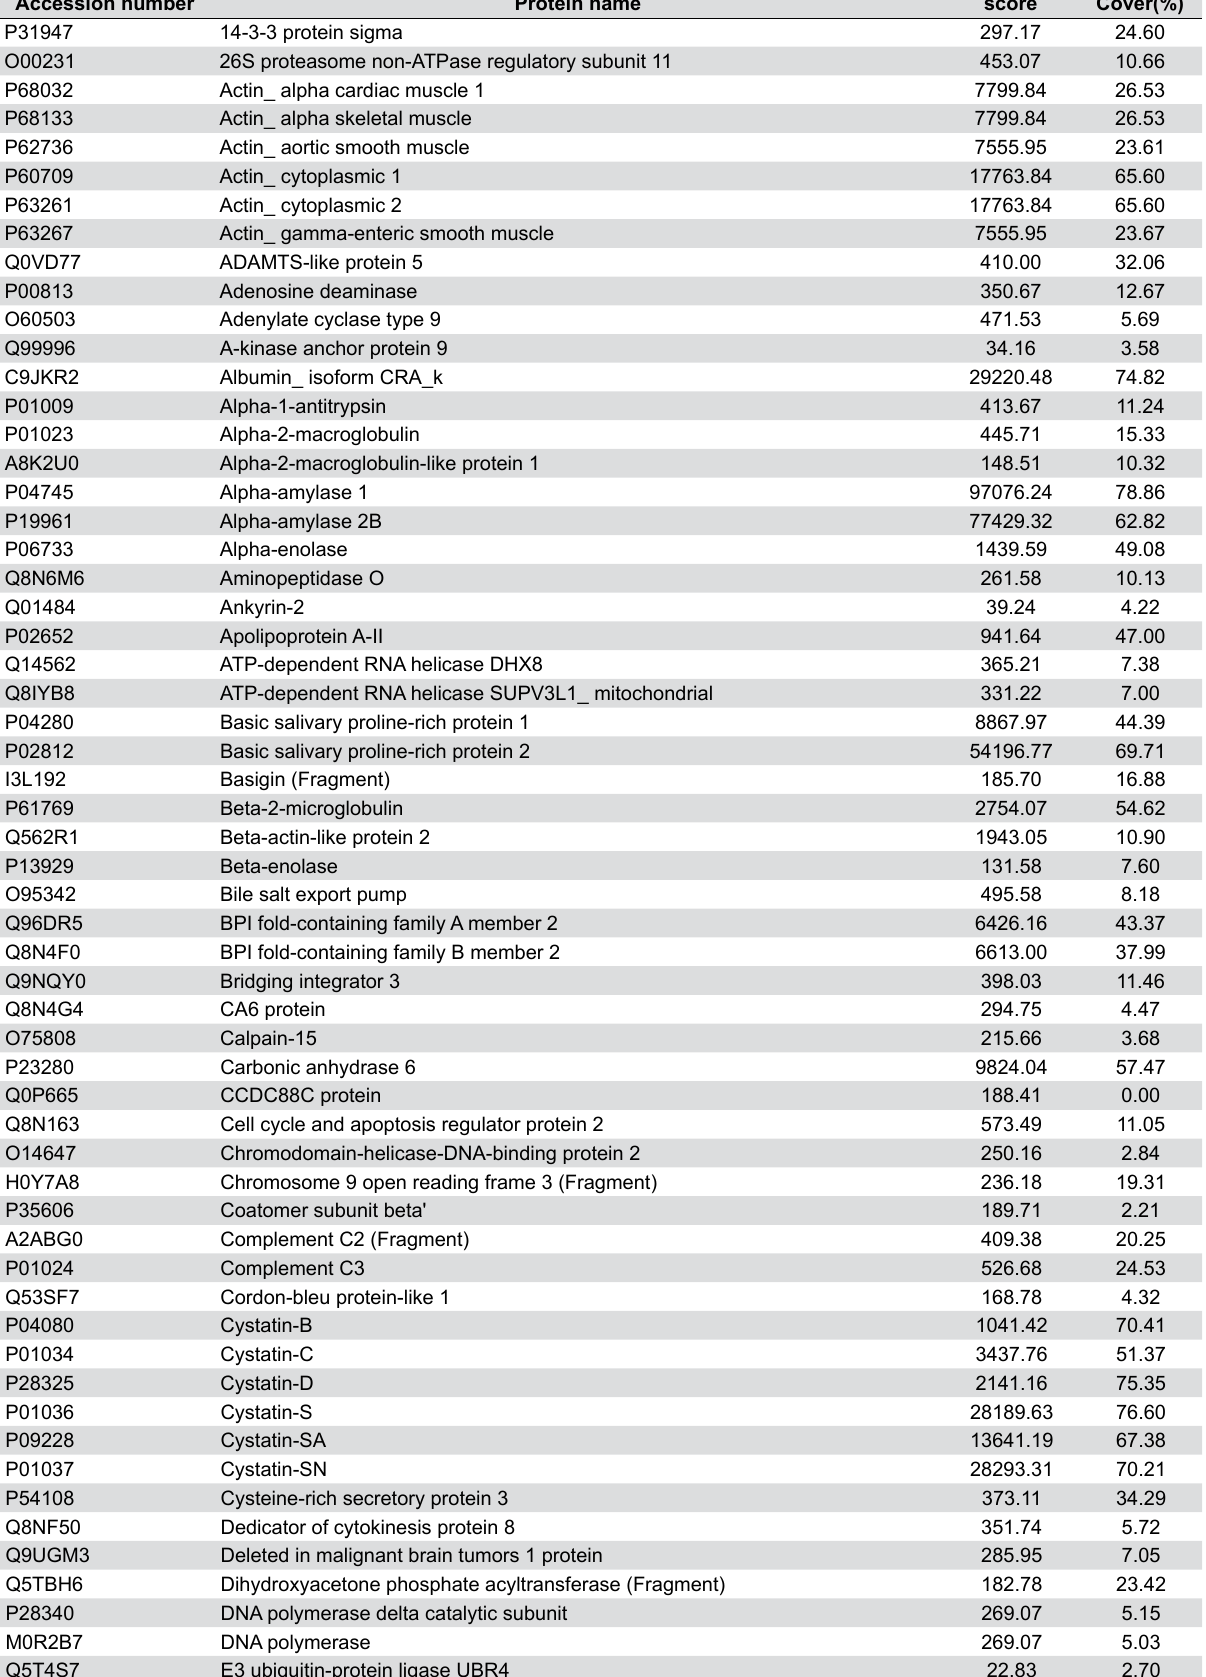
Table 4- Proteins of the saliva identified in only in the individual